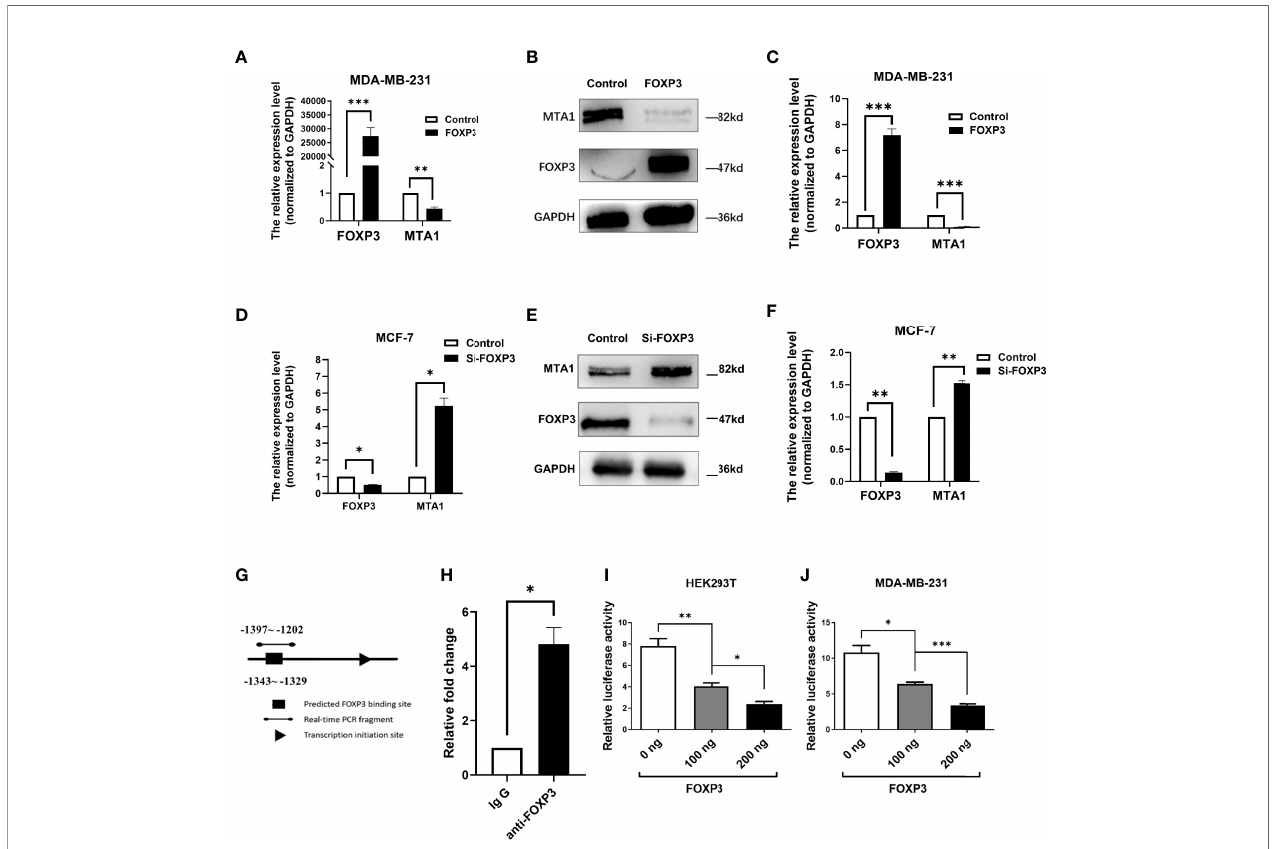
FIGURE 2 | FOXP3 binds to the MTA1 promoter and reduces its expression. Real-time PCR was performed to determine the mRNA levels of FOXP3 and MTA1 in MDA-MB-231 cells (A) and the mRNA levels of FOXP3 and MTA1 in MCF-7 cells (D) in the control group and FOXP3 group. Western blotting was used to determine the protein expression levels of FOXP3 and MTA1 in MDA-MB-231 cells (B) and MCF-7 cells (E) in the control group and FOXP3 group. (C, F) Grey-level analysis of the bands in (B, E) respectively. (G) Potential FOXP3 binding sites in the promoter region of the MTA1 gene. (H) The ChIP assay showed that FOXP3 had a stronger ability to bind to speci fi c sequences in the MTA1 promoter than to the negative IgG control. The dual-luciferase reporter assay showed that transfection with the FOXP3 overexpression plasmid signi fi cantly reduced the transcriptional activity of the MTA1 gene promoter in HEK293T cells (I) and MDA-MB-231 cells (J) in a dose-dependent manner. The data are shown as the mean ± s.e.m. ns, P > 0.05; *P < 0.05; **P < 0.01; and ***P <